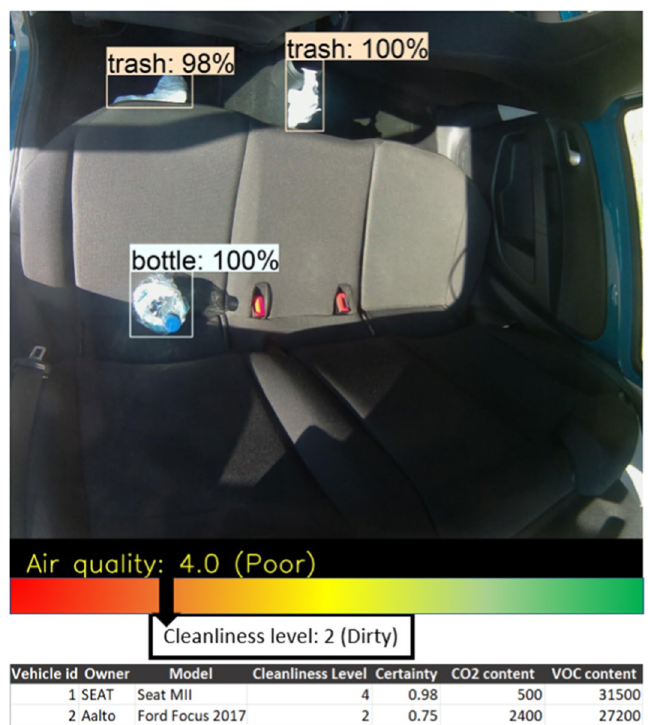
Fig. 31 A sample of the expected outcome of the future integration between the vision-based detection system and IAQ monitoring